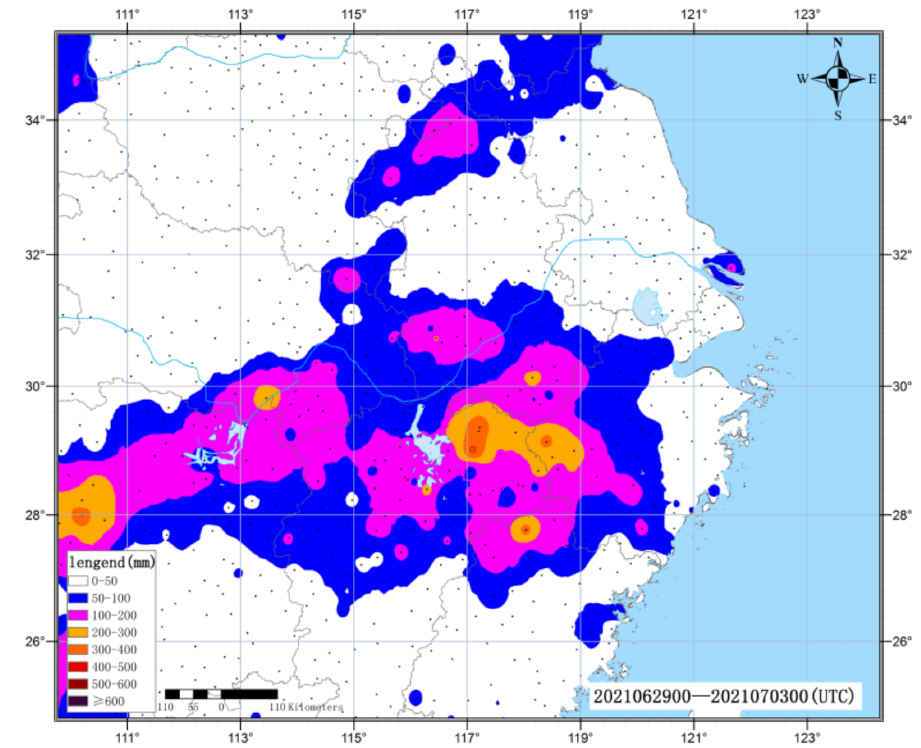
Figure 2. Distribution of observed accumulated rainfall from 29 June to 2 July